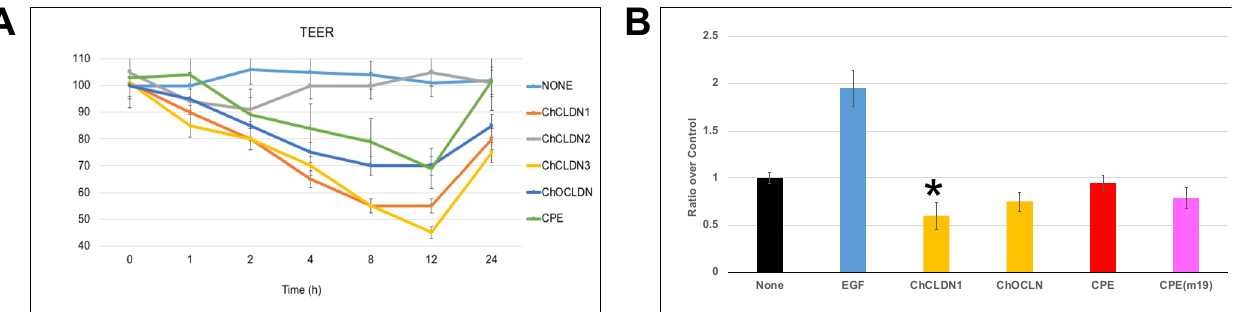
Figure 3. MBP-CC1 in vitro experiments. ( A ) Caco-2 cells were treated with MBP-CC1, MBP-CC2, MBP-CC3 or MBP-COC. No addition of proteins or MBP-CPE was used for controls. The graph represents the change in TEER compared to the control (no addition of protein). Following treatment, TEER was monitored for 24 h (intervals of 0, 1, 2, 4, 8, 12, and 24 h). Three experiments are averaged in the graph (±SD). ( B ) Cal27 cells were treated with EGF, MBP-CC1, MBP-COC, MBP-CPE or MBP-CPE(m19). After 24 h of treatment, cells were prepared for the proliferation assay (ATPlite, Perkin Elmer). Proliferation is reported as the average of 4 separate experiments (±SD). For statistical analysis, we employed t-test, and the asterisk represents a statistical significance ( p < 0.001).